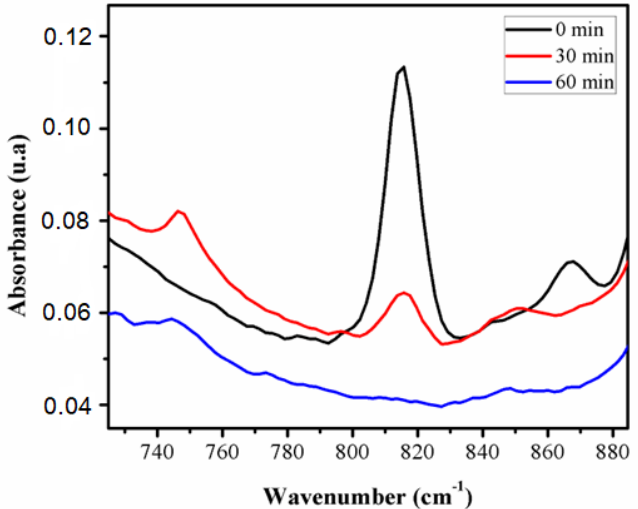
Figure 4. Time evolution of the acrylate double bond absorbance present in the reactive mixture under photo-polymerization.